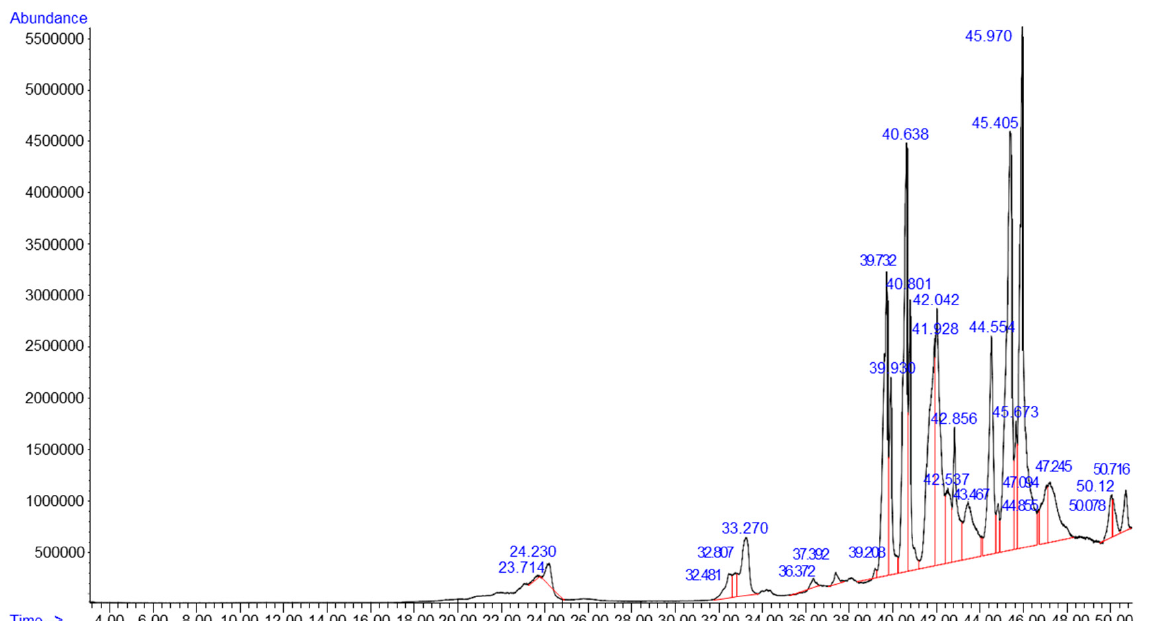
Figure 3. Gas chromatogram of diesel fuel.